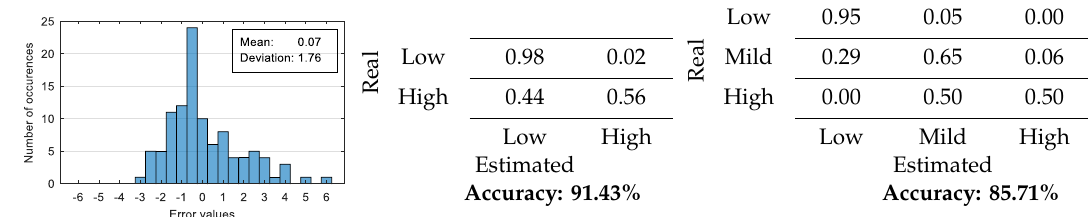
Table 7. Distribution of estimation errors and confusion matrices for levels 2 and 3 — using two features.